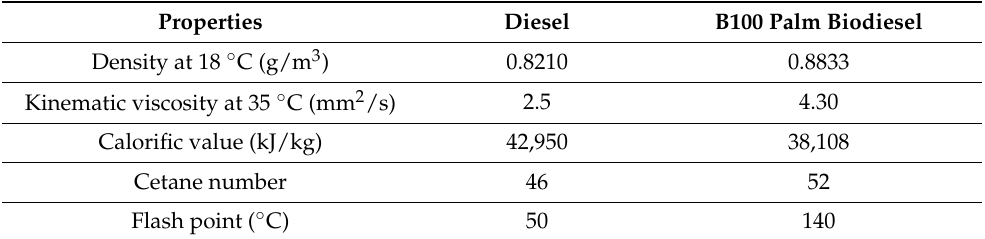
Table 6. List of the Physical and Chemical Properties of the Biodiesel and Diesel fuels. Properties